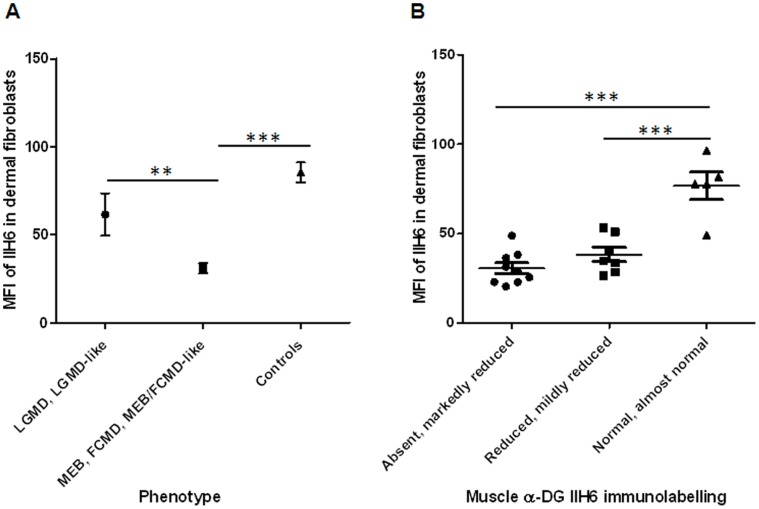
Comparison of the mean fluorescence intensity (MFI) of α-DG glycosylation in patient fibroblasts to respective patient phenotypic severity and skeletal muscle α-DG IIH6 immunolabelling.(A) Fibroblasts from patients with relatively mild phenotypes (LGMD, LGMD-like without brain involvement, includes P1, P5, P6, P12, P13, and P16 from table 1) have a significantly (p = 0.008) higher average MFI value (61.5±12.1) than fibroblasts from patients with more severe dystroglycanopathy phenotypes (MEB, FCMD, MEB/FCMD-like, includes P2, P7, P8, P9, P10, P14, P15, P18, P19, P20 with an MFI average of 31.0±2.9). (B) In patient fibroblasts, a decrease in the MFI of IIH6 obtained by flow cytometry concomitant with a decrease in the intensity of immunolabelling in skeletal muscle sections was observed. Skeletal muscle sections which were described as ‘absent’ or ‘markedly reduced’ (table 1) for IIH6 yielded an average MFI from the respective fibroblasts of 30.7±3.1 (n = 9). Sections described as ‘reduced’ for IIH6 yielded an average MFI value of 38.3±4.0 (n = 7) from the respective fibroblasts. Finally, sections which were described as ‘normal’ (or almost normal) yielded MFI values of 76.7±7.7 (n = 5) from the respective fibroblasts. There is a significant difference in the MFI between both groups reduced for skeletal muscle α-DG IIH6 immunolabelling and the group described as normal or almost normal (p<0.0001 for absent/markedly reduced, p = 0.0007 for reduced). *** = p<0.001, ** = p<0.01 (unpaired t-test). In all cases values are described as mean fluorescence intensity ± standard error of the mean (SEM).